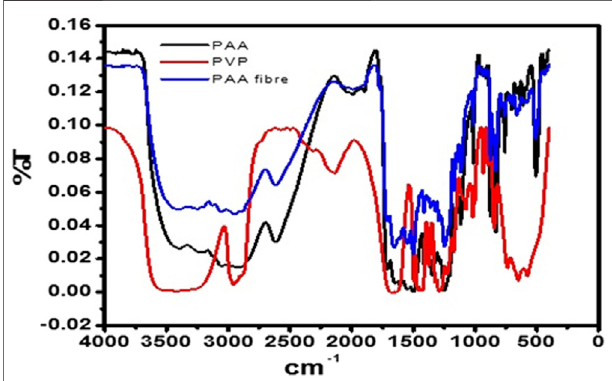
FIGURE 2 | FTIR spectrum of pure PAA powder, PVP, and PAA nano fi